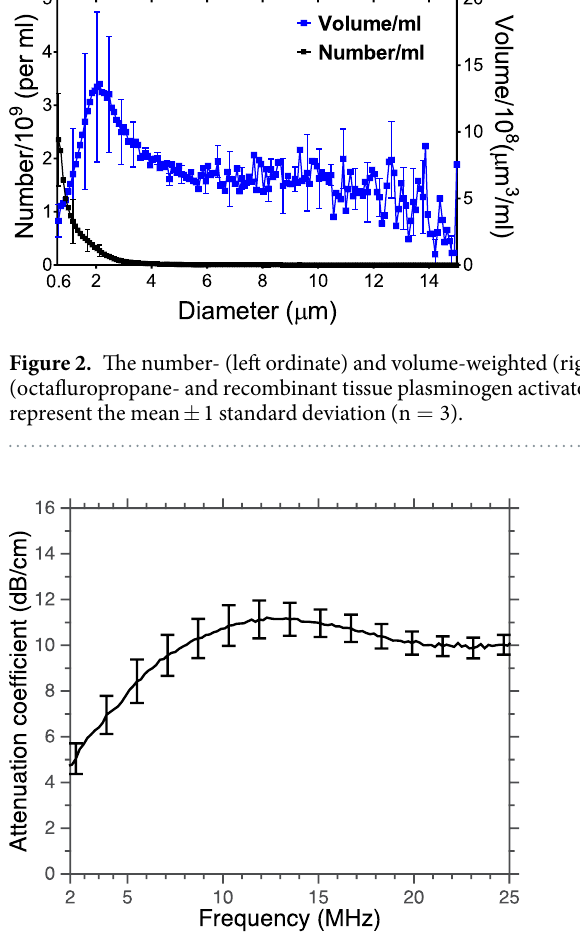
Figure 3. The attenuation coefficient of OFP t-ELIP (octafluropropane and recombinant tissue plasminogen activator-loaded echogenic liposomes) measured as a function of frequency (2–25 MHz). The error bars represent the mean ± 1 standard deviation (n =